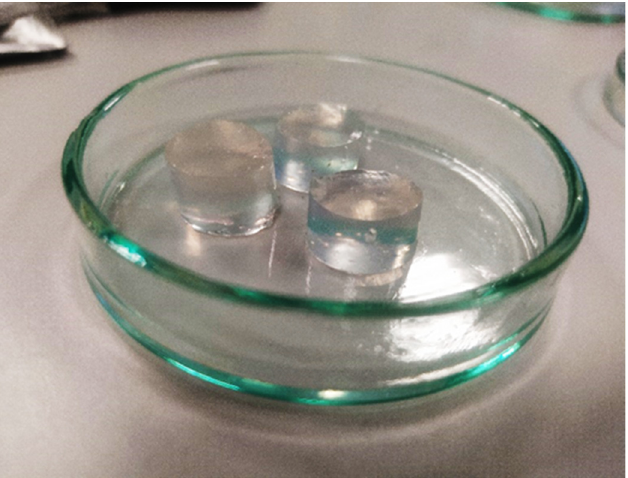
Figure 1. A sample photo of Coll/BG + 5%TA material, cut into a cylindrical shape for mechanical testing.